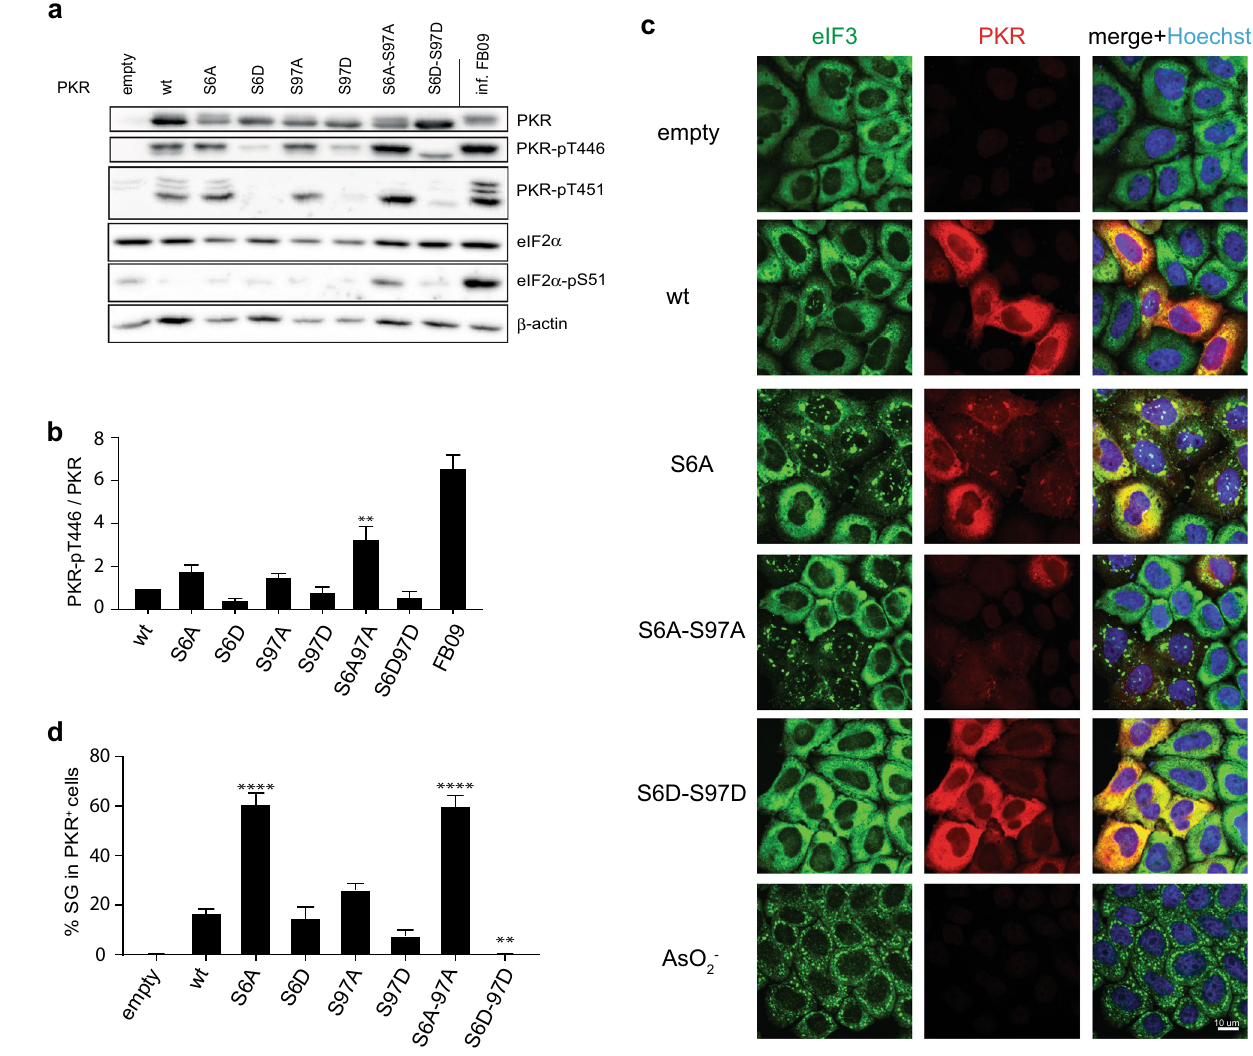
Figure 2. Mutations of Ser6 and Ser97 regulate PKR activation. PKR-KO cells were transfected with vectors expressing either wild type (wt) or mutant PKR, as indicated. After 48 h, cells were lysed for western blot or fixed for immunofluorescence analysis. ( a ) Representative western blots showing total and phosphorylated forms of PKR and eIF2α. β-actin was detected as a loading control. ( b ) Quantification of the phospho-Thr446 (PKR-pT446) / total PKR ratio on western blots (n = 4). ( c ) Confocal microscopy images showing spontaneous stress granule formation (eIF3, green) in cells transfected with PKR (red) expressing vectors. Arsenite treatment (NaAsO 2 ) for 30 ′ at 37 °C was used as a positive control for SG formation. ( d ) Percentage of stress granule- positive cells counted among PKR-positive (PKR + ) cells. Western blots were quantified by chemiluminescence using a CCD camera (Fusion Solo-S, Vilber) and quantified within the limits of the dynamic range, using software Bio1D version 15.08. Graphs (generated with Microsoft Excel 2011) show mean ± SEM (n = 4); 1-way ANOVA (Graphpad Prism 7) was used to compare PKR mutants to wt PKR. Microscopy images were acquired using Zen